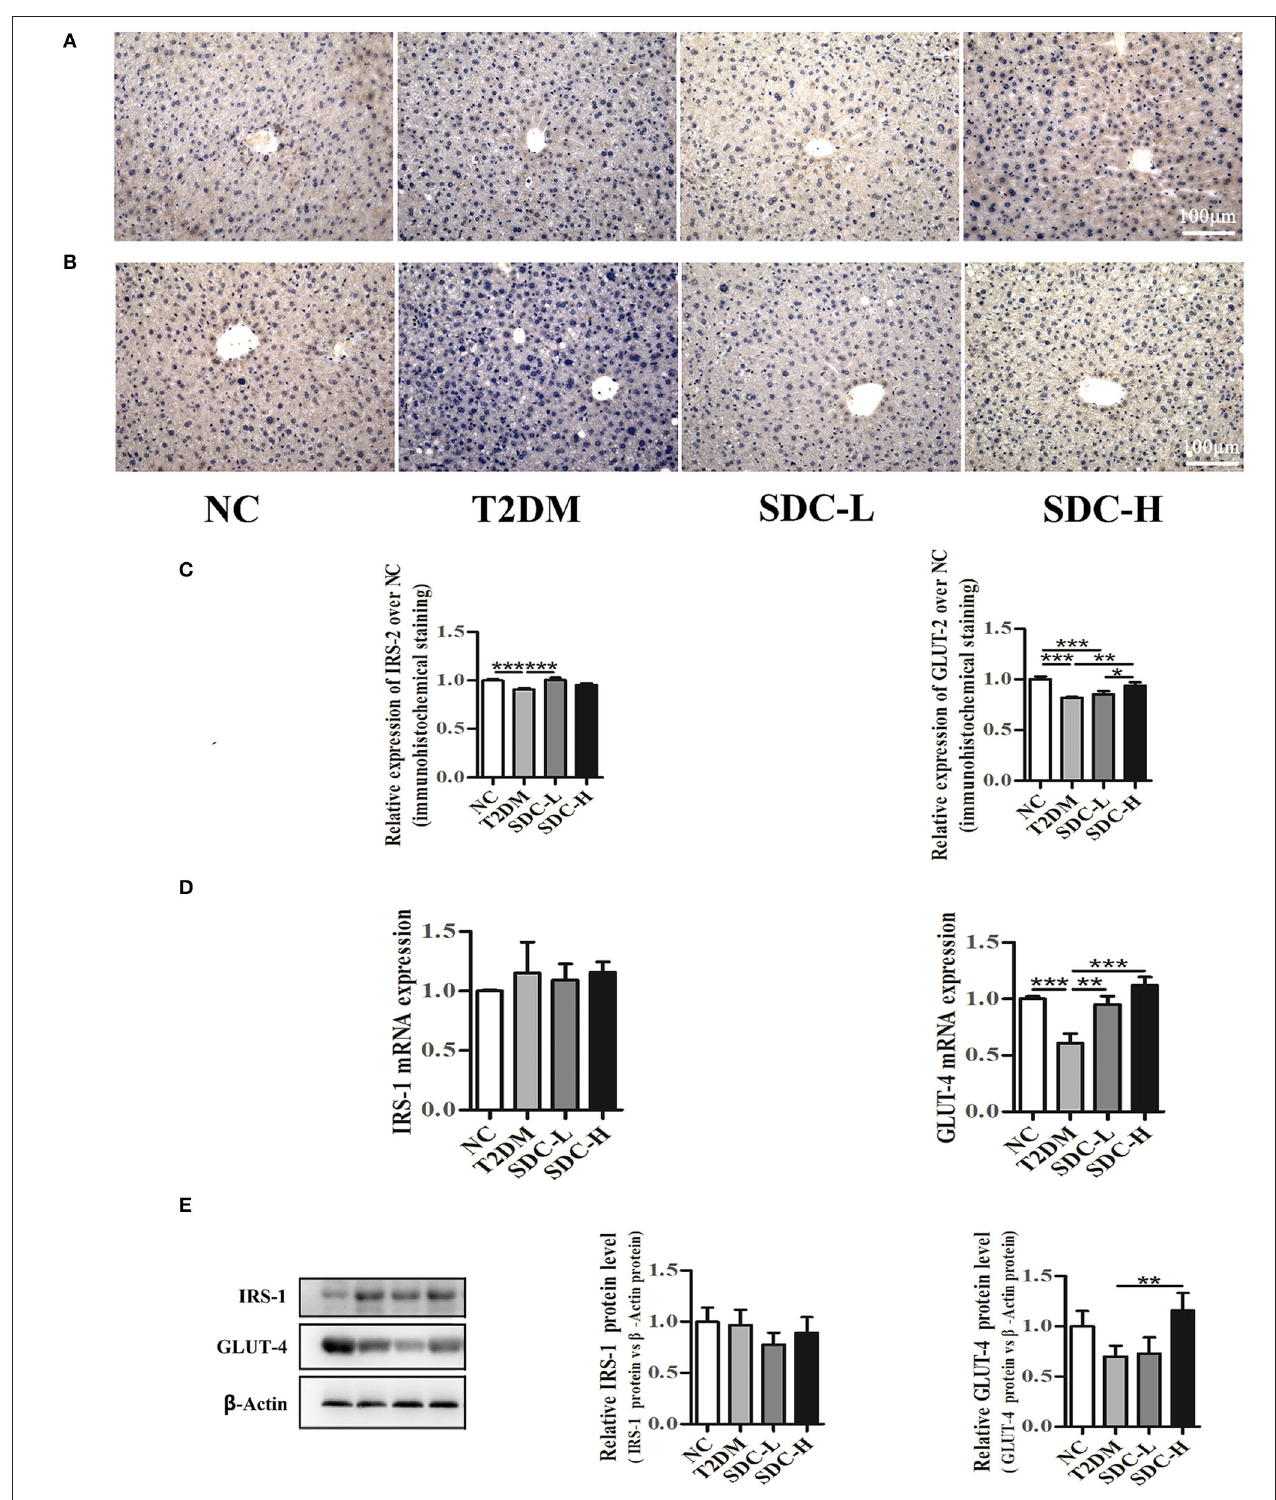
FIGURE 5 | Immunohistochemistry analysis of IRS-2 (A) and GLUT-2 (B) in liver tissues, n = 5; Relative expression of IRS-2 and GLUT-2 in liver tissues, n = 5 (C) ; mRNA levels of IRS-1 and GLUT-4 in skeletal muscle tissues, n = 8 (D) ; protein levels of IRS-1 and GLUT-4 in skeletal muscle tissues, n = 6 (E) . * P < 0.05, ** P < 0.01, *** P <